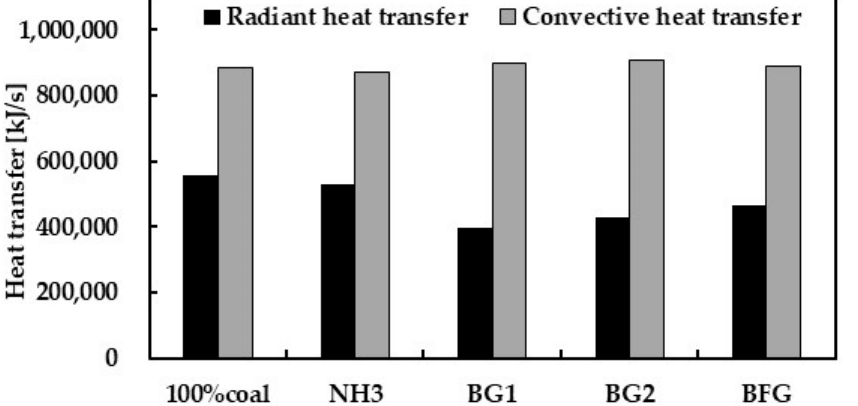
Figure 9. Comparing the distribution of heat transfer in the boiler between co-firing ammonia and co-firing three low caloric value gases at co-firing ratio of 20%.